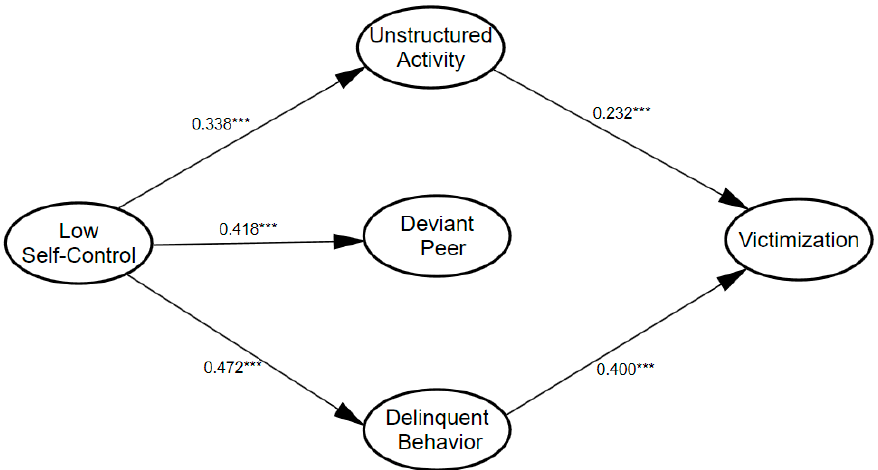
Figure 3. Structural model (N = 1057). Note: χ 2 (32) = 140.957, p = 0.00, GFI = 0.978, CFI = 0.953, SRMR = 0.029, CN = 347, and RMSEA = 0.057; 90% CI = [0.047, 0.067]. Values are presented as standardized coefficients, and only statistically significant paths are shown. All other covariates are controlled but not presented in the model. *** p < 0.001.